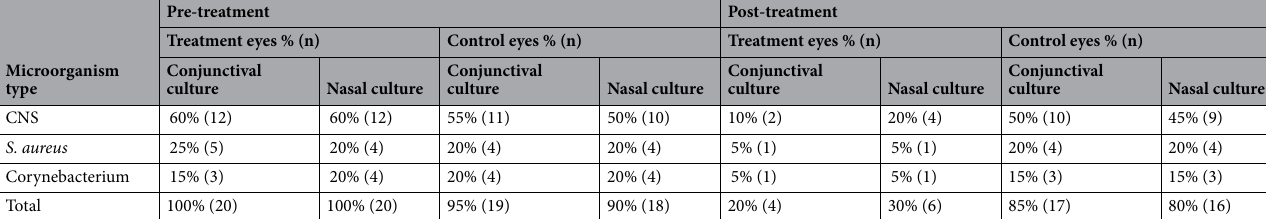
Table 1. The distribution of isolates from conjunctival and nasal cultures prior to and after antibiotic therapy in the treatment and control eyes. The numbers show the percent and the number of positive cultures for each